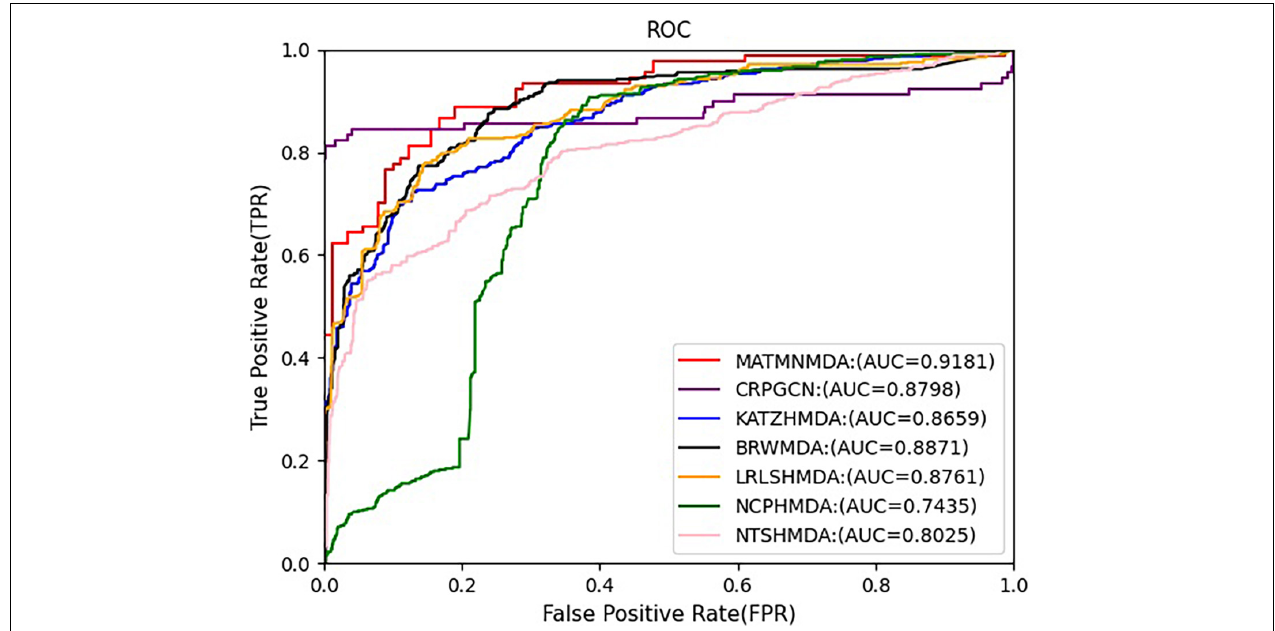
FIGURE 9 | Comparison of AUC for MATMNMDA and baselines on HMDAD